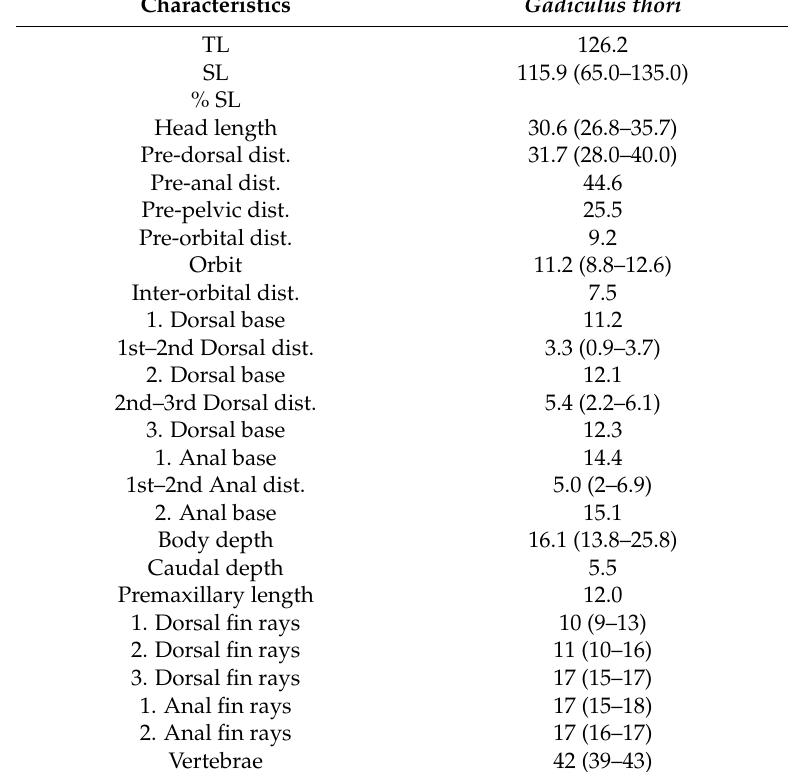
Table 1. Meristics and morphometrics of Gadiculus thori (ZMUB 14683) caught off Southeast Greenland in 2012, providing a new range extension into the Western North Atlantic (Figure 2). The specimen was compared to G. thori “northern” specimens presented by Raitt [23] from off the west coast of Scotland (ranges shown in